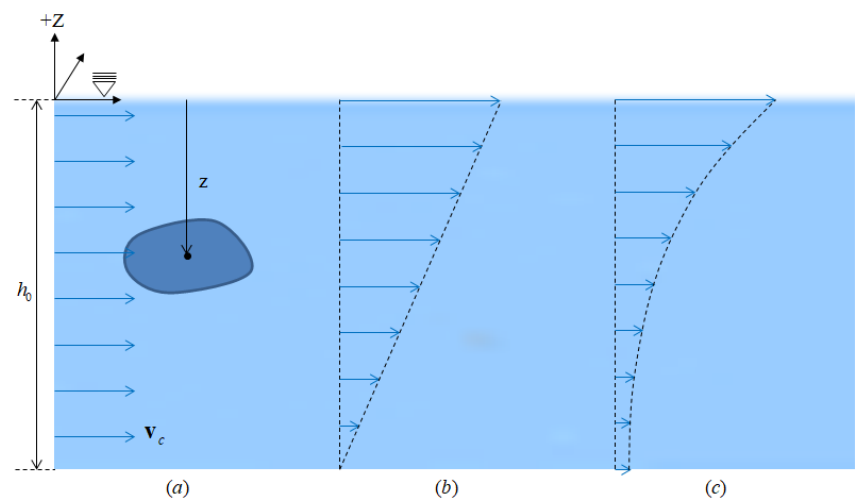
Figure 5. Three types of ocean current: ( a ) a constant, ( b ) a linear, ( c ) a parabolic.